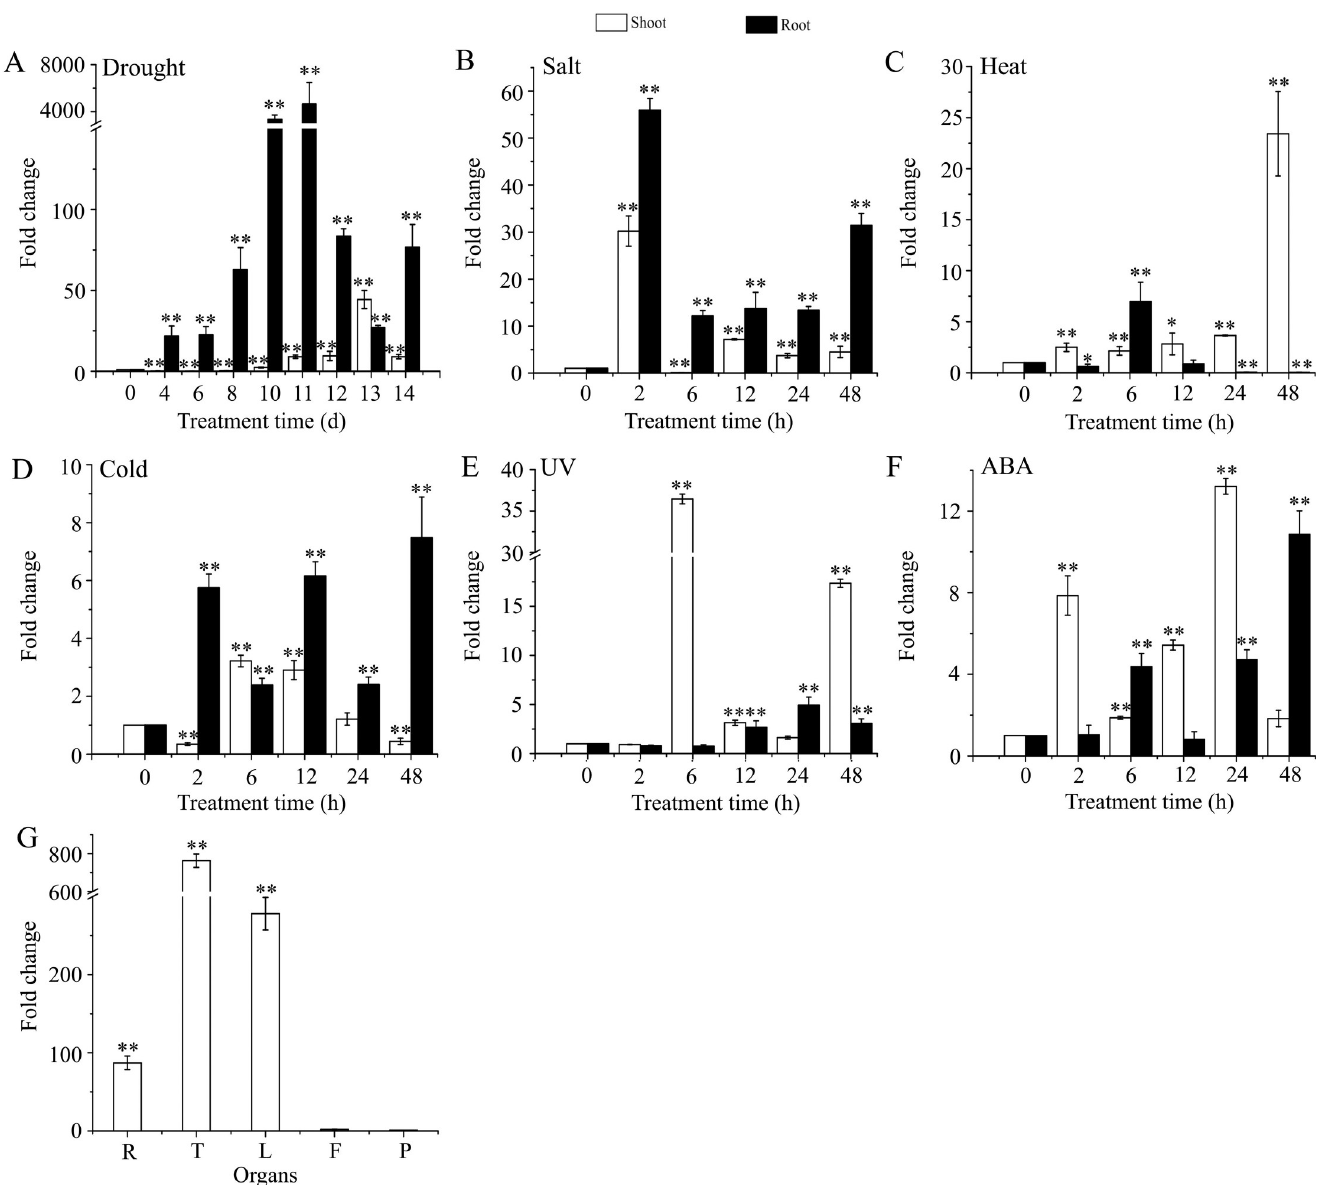
Fig 3. Expression patterns of AmDREB3 under different abiotic stress conditions and in various organs. One-month-old seedlings were subjected to different abiotic stressors or ABA treatment, and the expression changes of AmDREB3 in the shoots and roots are presented. (A) The expression changes during the 14 d drought treatment. The transcript level at 0 d was used as the control. (B) to (F) The expression changes during the salt (watering the seedlings with 350 mM NaCl solution), heat (42˚C), cold (4˚C for 24 h, 0˚C for 12 h, and -6˚C for 12 h, in total 48 h), UV-B (40 w), and ABA (100 μ M) treatments for 2 to 48 h, respectively. (G) The expression pattern in different organs of naturally growing A . mongolicus shrubs in the wild. R, T, L, F, and P represent roots, twigs, leaves, flower buds, and immature pods, respectively. The α -tubulin gene of A . mongolicus was used as an internal reference gene. Data are presented as means ± SDs (n = 3). Asterisks and double asterisks indicate significant differences between each stress treatment or each organ and its control at p < 0.05 and < 0.01, respectively.